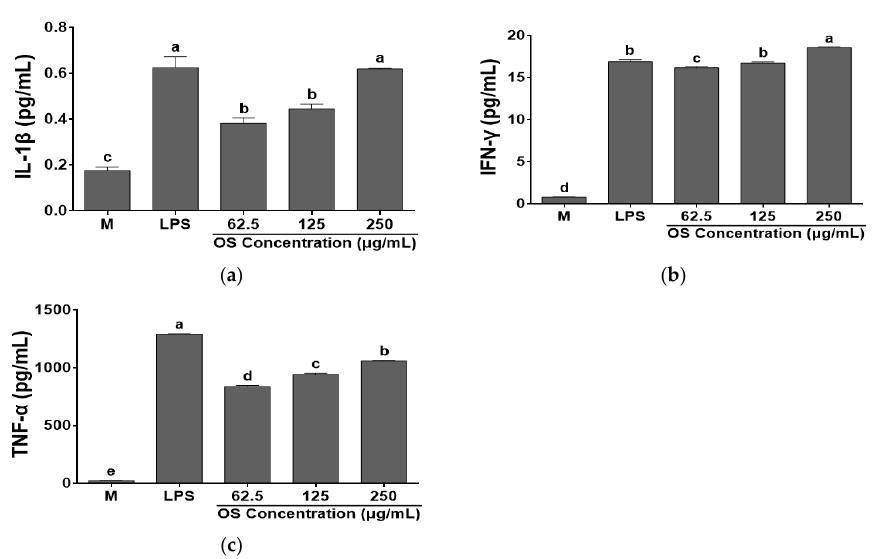
Figure 5. Effects of A. cepa skin (OS) extracts on the productions of ( a ) IL-1 β , ( b ) IFN- γ , and ( c ) TNF- α by RAW 264.7 cells. Data was expressed as the mean ± SEM. a–e Different letters are significantly different at p < 0.05.